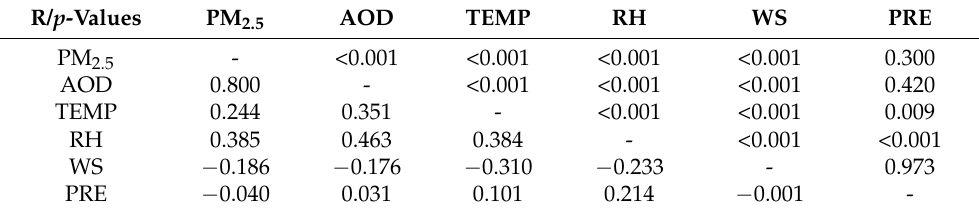
Table 1. Correlation coefficient and p -values between PM 2.5 and influencing factors at Dalian. R/ p -Values PM 2.5 AOD TEMP RH WS PRE PM 2.5 - <0.001 <0.001 <0.001 <0.001 0.300 AOD 0.800 - <0.001 <0.001 <0.001 0.420 TEMP 0.244 0.351 - <0.001 <0.001 0.009 RH 0.385 0.463 0.384 - <0.001 <0.001 WS − 0.186 − 0.176 − 0.310 − 0.233 - 0.973 PRE − 0.040 0.031 0.101 0.214 − 0.001